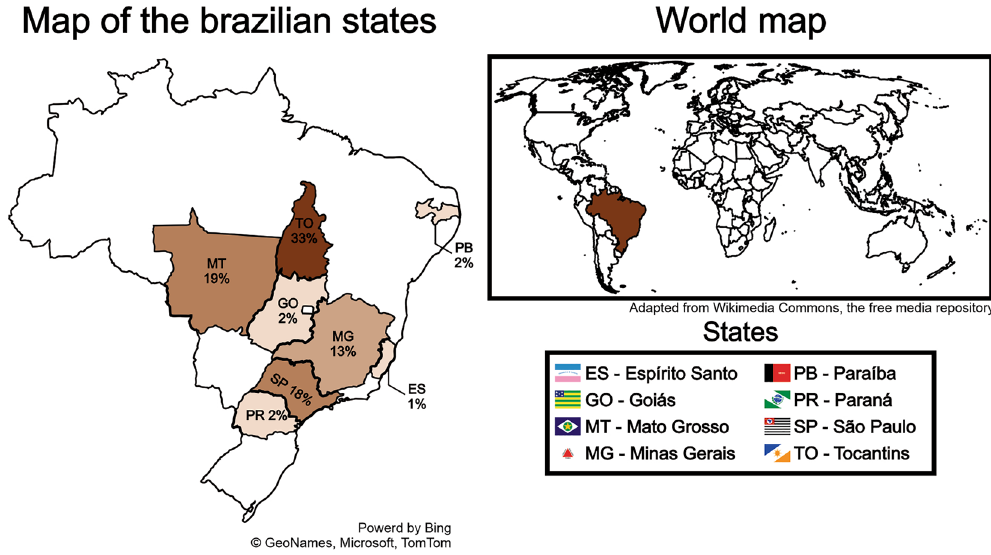
Figure 4. Geographic distribution of selected k sat